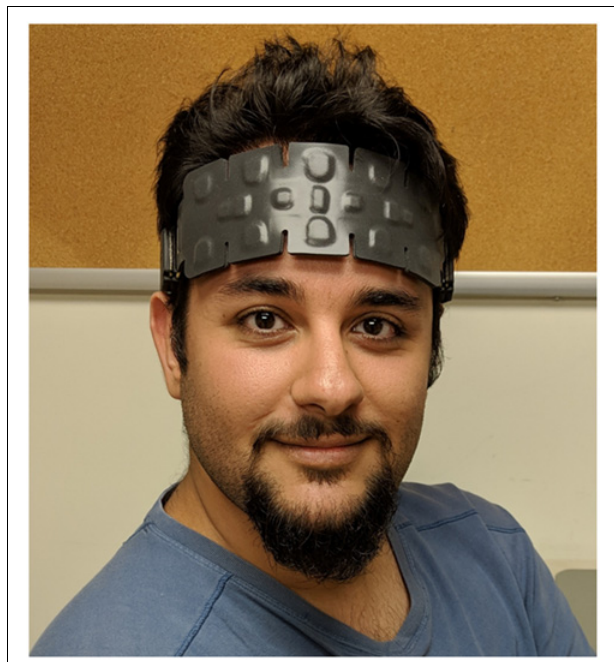
FIGURE 2 | fNIR (cid:114) sensor pad used for data collection. Written informed consent was obtained from the individual to publish this